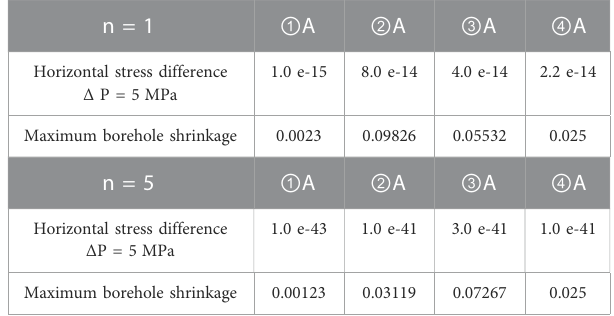
TABLE 6 The pre-coef fi cient A and the exponent n (Layer No. 3), in the case of n = 1 and